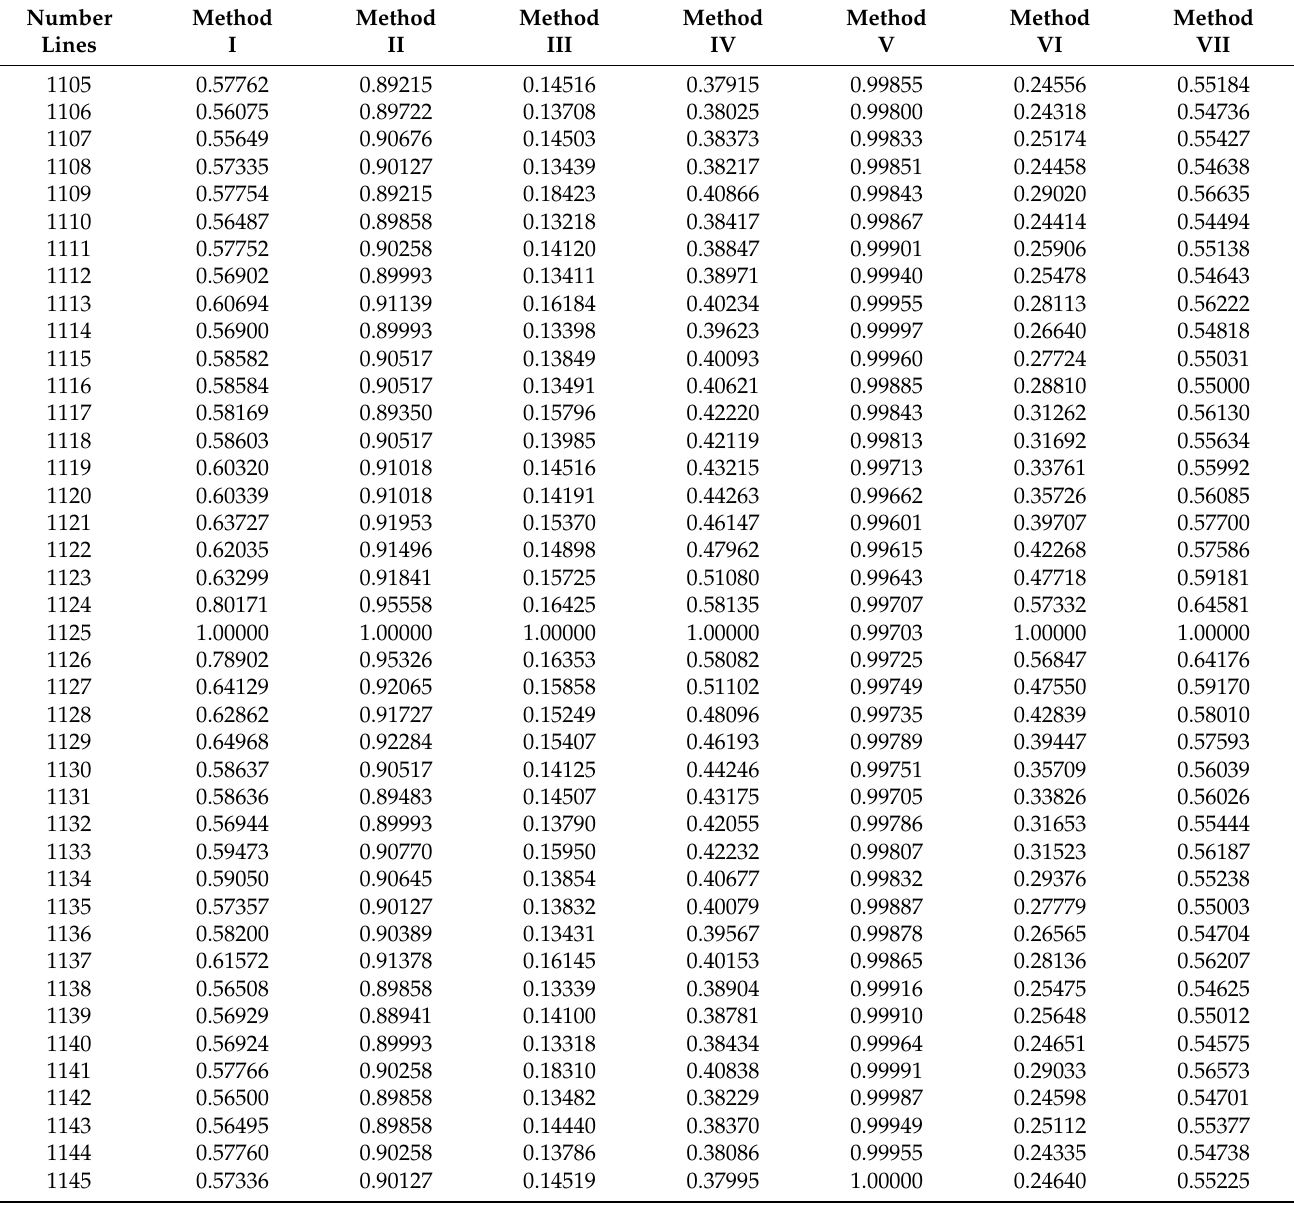
Table 2. Normalized values (in relation to the maximum value) of the variability of measures as a function of the number of image lines, supporting the determination of the correct number of lines of the image reproduced for the source image in the form of a picture from Figure